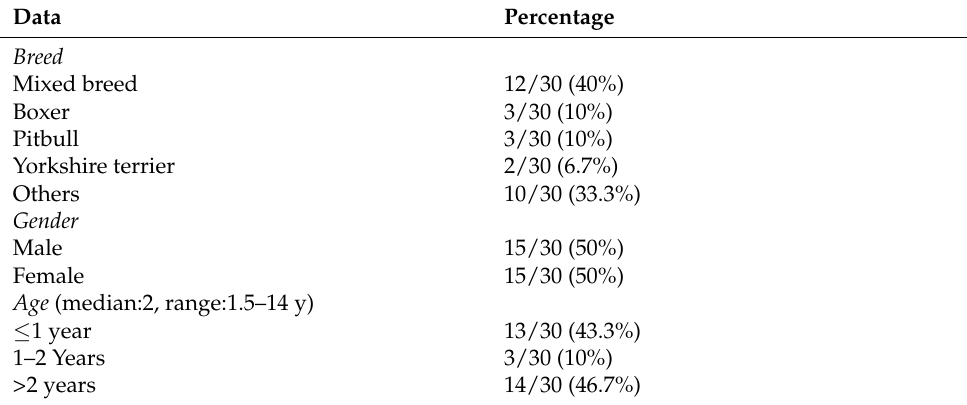
Table 1. Signalment data of the 30 dogs with